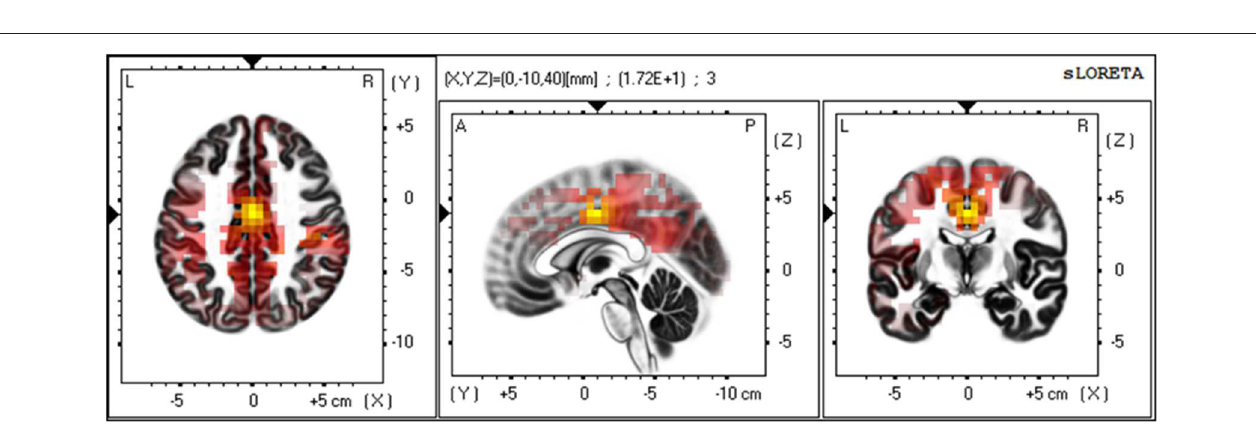
FIGURE 5 | Mean change in the power of low-beta oscillations at outcome period during the CH session. We found a significant simple main effect between the low-beta oscillations in the Win and Lose trials during the Outcome period [F4: F (1, 45) = 17.752, p < 0.05, FCz: F (1, 45) = 18.859, p < 0.05, FC4: F (1, 45) = 25.199, p < 0.05, FWER corrected]. * p < 0.05.